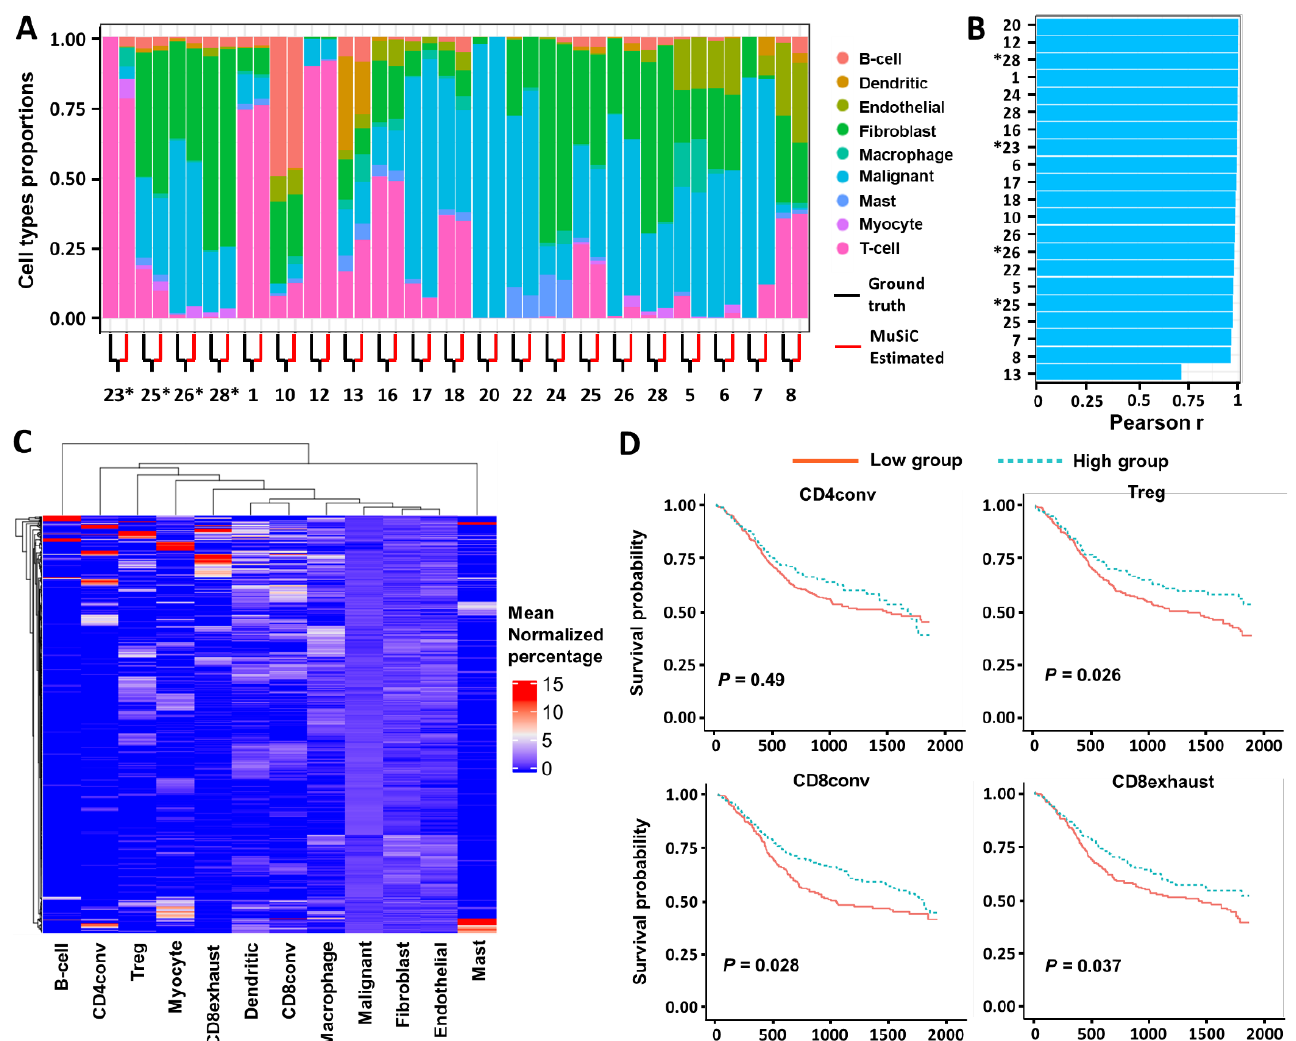
Figure 4. MuSiC deconvolution based on T-cell subtypes/subpopulations. ( A ) Comparison of ground-truth cell proportions with the estimated proportions by MuSiC for all HNSCC samples. The validation run used a combination of 18 (reference) and 3 (validation). The ground-truth and estimated cell proportions are paired for each sample and demarcated by black and red lines, respectively. Sample tumor numbers shown with an asterisk (*) indicate metastatic samples. ( B ) Concordance between cell type proportions measured by scRNA-seq (ground truth) and MuSiC for all HNSCC samples. The validation run used a combination of 18 (reference) and 3 (validation). The correlation is calculated by Pearson method and samples have the same naming criteria as in ( A ). ( C ) Heatmap of the relative cell fractions of the 12 cell types (eight major cell types and four T-cell subtypes) for each sample estimated by MuSiC. The percentage is normalized by the corresponding mean within each cell type. ( D ) Association between cell proportions and overall survival in patients with HNSCC profiled by TCGA. Estimated cell proportions were stratified by a half–half split, and the separation between survival curves was evaluated using a log-rank test. Table 3. Cox proportional-hazard regression analysis for survival and T reg proportions estimated by CIBERSORTx and MuSiC (prop., proportion; HR, hazard ratio; CI, confidence interval; ref, reference).